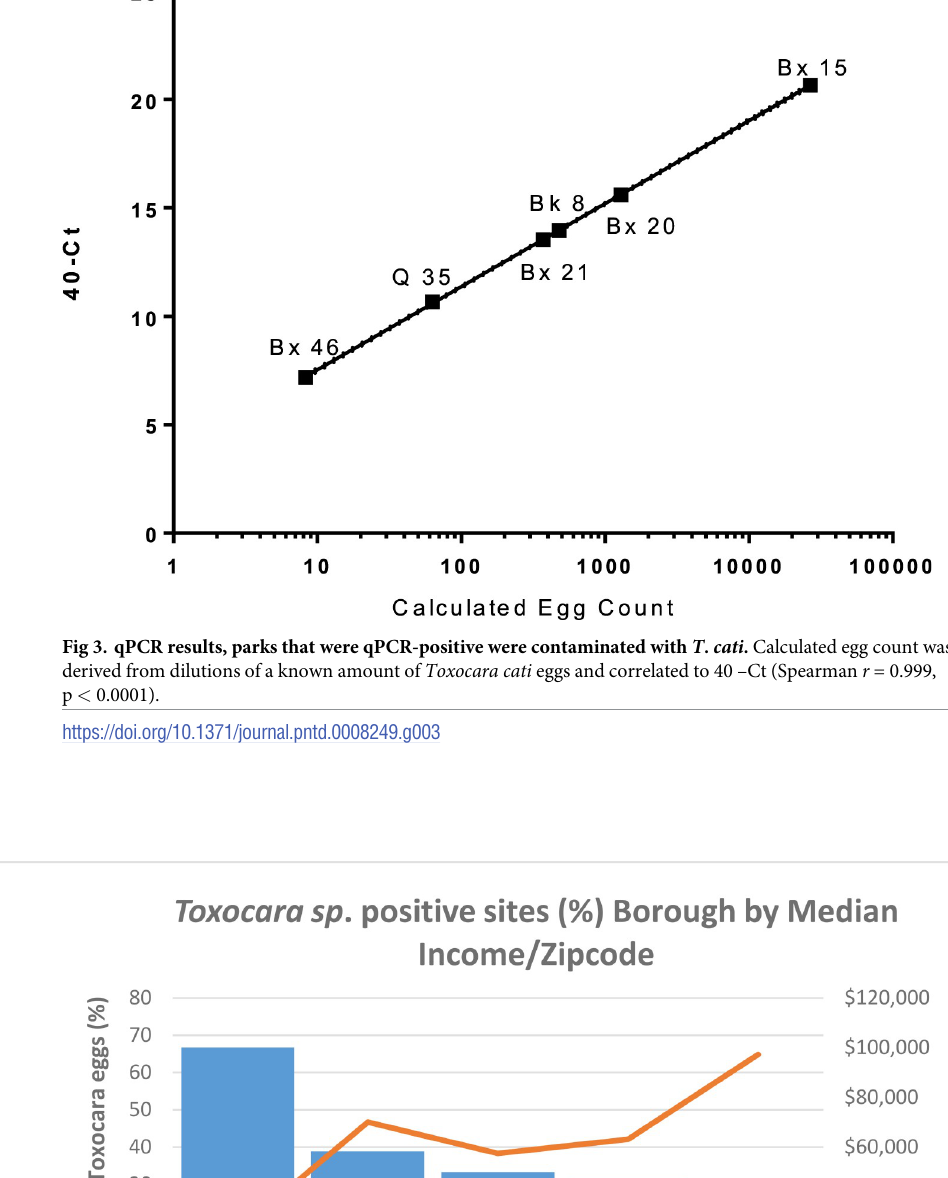
PLOS NeglectedTropical Diseases | https://doi.org/10.1371/journal.pntd.0008249 May 5,